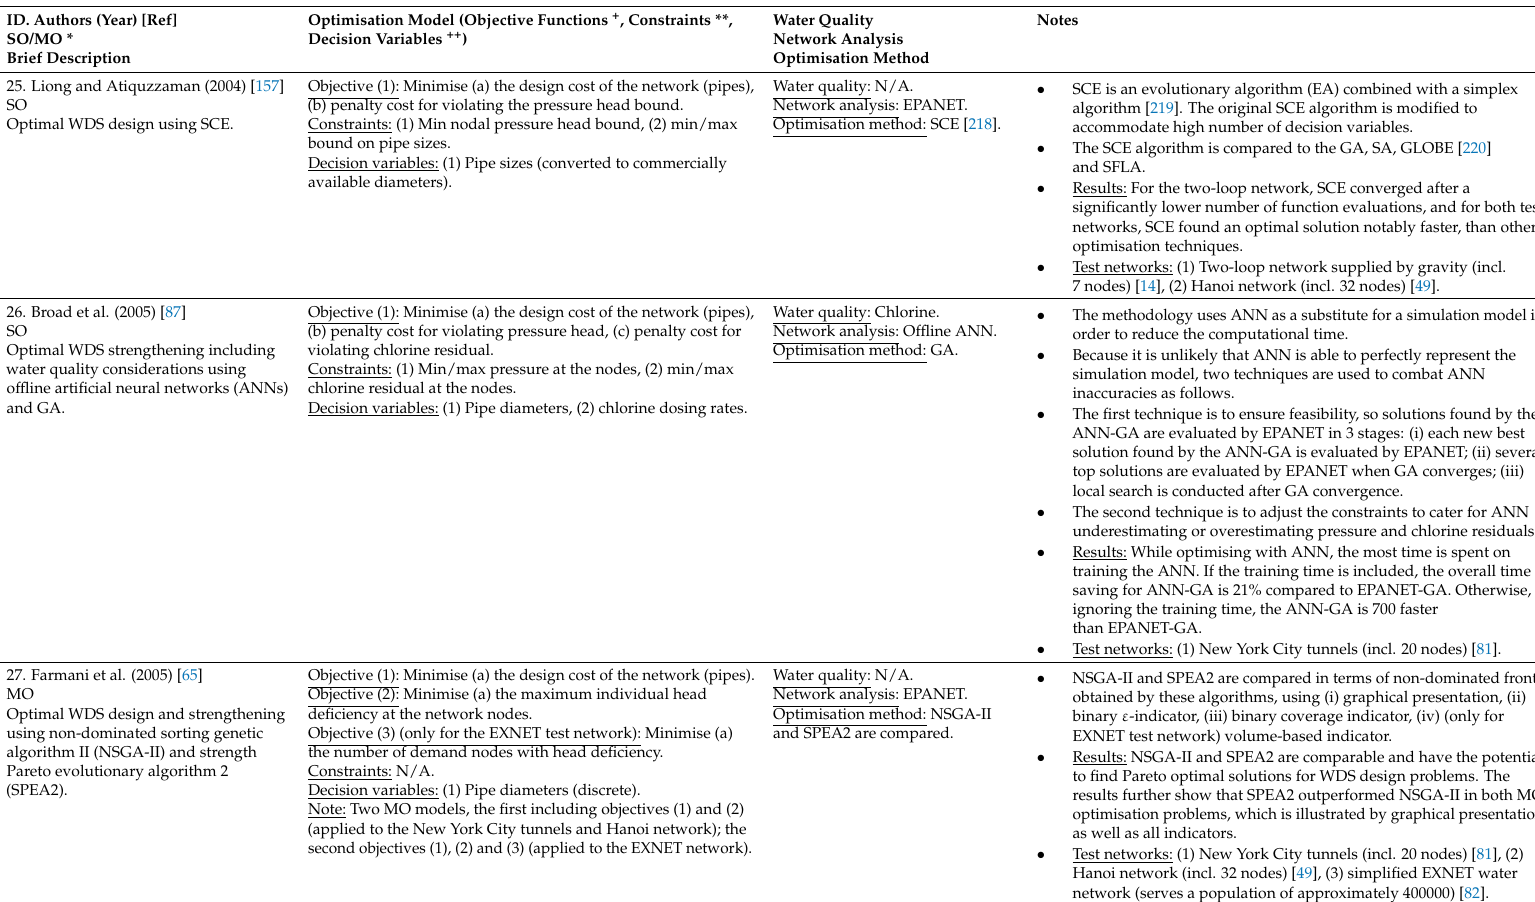
Optimal WDS design and strengthening using non-dominated sorting genetic algorithm II (NSGA-II) and strength Pareto evolutionary algorithm 2